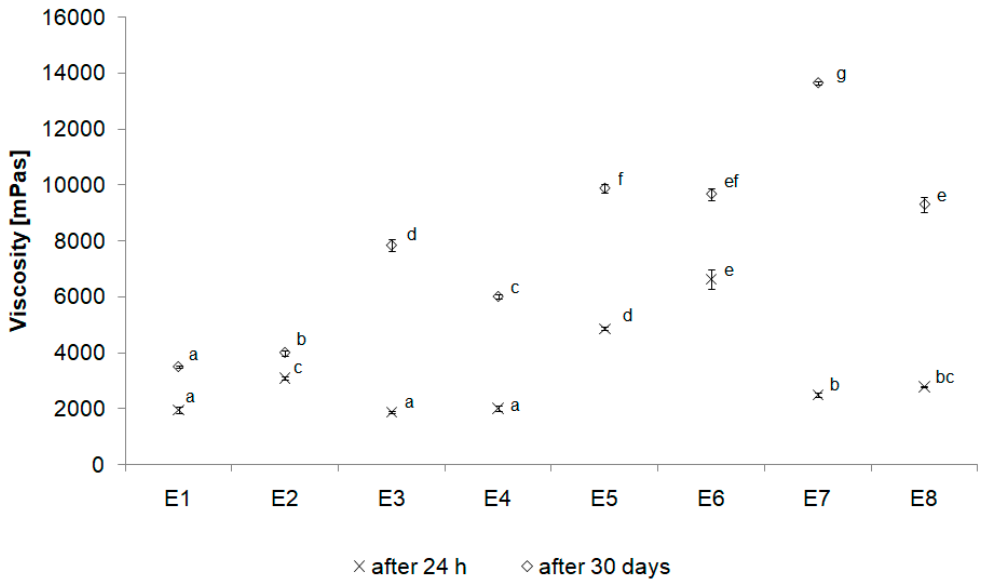
Figure 7. Viscosity of the emulsions after 24 h from their manufacturing and 30 days of storage (as a mean value of 3 determinations ± SD) Different letters indicate statistically significant difference ( p < 0.05).